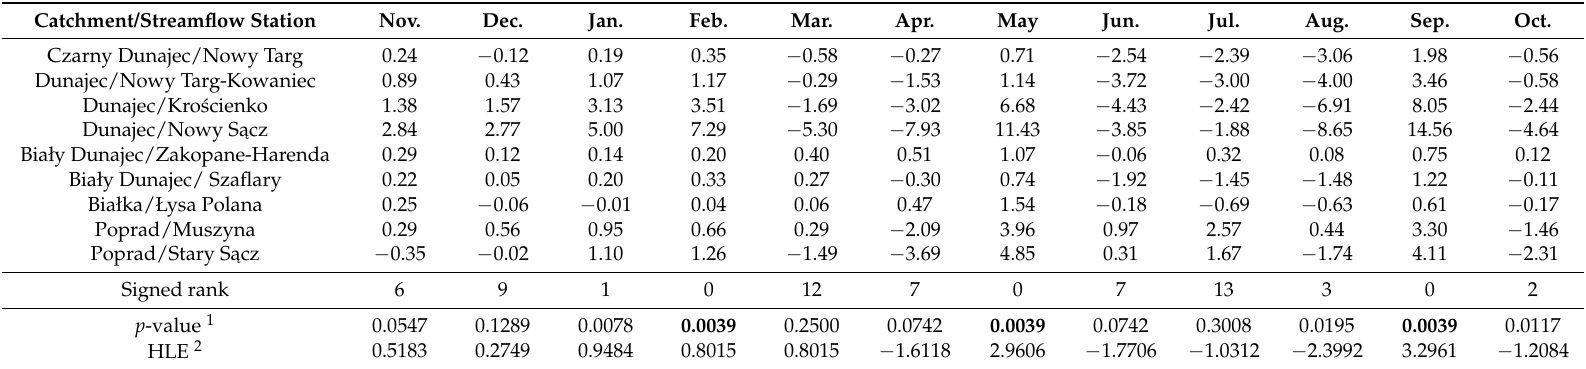
Table 5. Difference in mean monthly discharge (m 3 · s − 1 ) between the most recent 30-year period (1986–2015) and the previous period (1961–1985). According to the Wilcoxon signed rank test with the Bonferroni correction, the median of the difference in discharge for each month is significant at p < 0.0042.